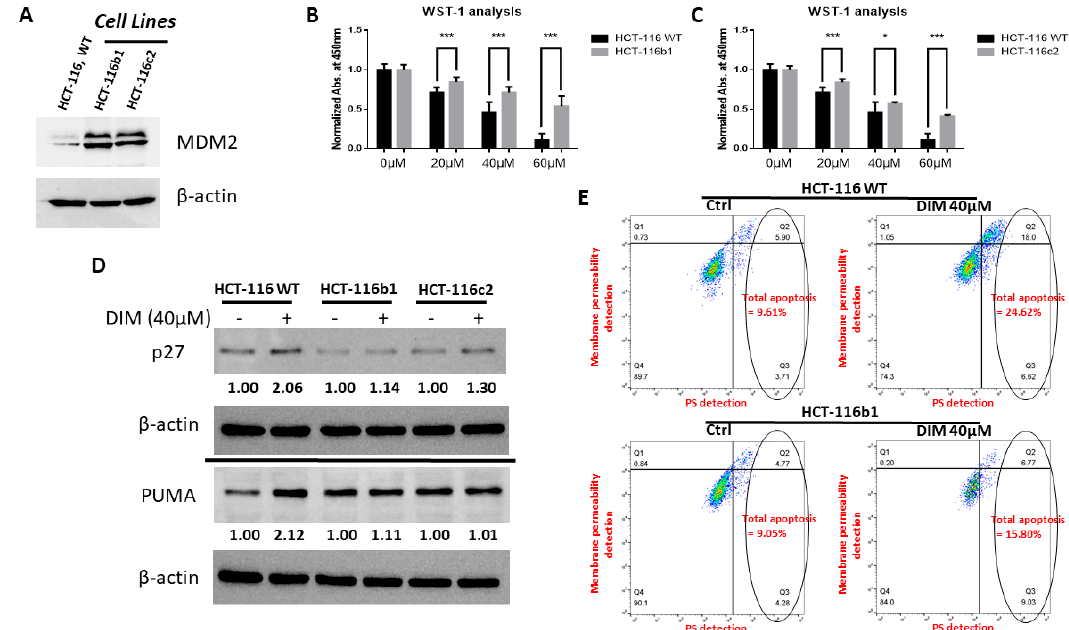
Figure 5. Overexpression of MDM2 reduced the anti-cancer activity of DIM. ( A ) MDM2 overexpressing clones of HCT-116 cells (HCT-116b1 and HCT-116c2) were created and MDM2 expression was confirmed by Western blotting. ( B , C ) Wild-type and MDM2 overexpressing clones of HCT-116 cells were treated with various doses of DIM for 24 h. DIM was added within 24 h of cell seeding to better compare the DIM e ff ect on wild-type and MDM2 overexpression cells. Cell proliferation was assessed by WST-1 assay as described in Materials and Methods. Asterisk represents significance levels (analyzed by t tests) with p ≤ 0.05 (*), p ≤ 0.01 (**), and p ≤ 0.001 (***). All experiments were repeated three times; data shown are mean values + SD. ( D ) Western blotting showed that DIM induced smaller amounts of PUMA and p27 proteins in MDM2 overexpressing cells compared with HCT-116 wild-type cells. The amount of change of protein was noted in numbers compared with the corresponding control group. ( E ) Flow cytometry showed DIM induced a higher